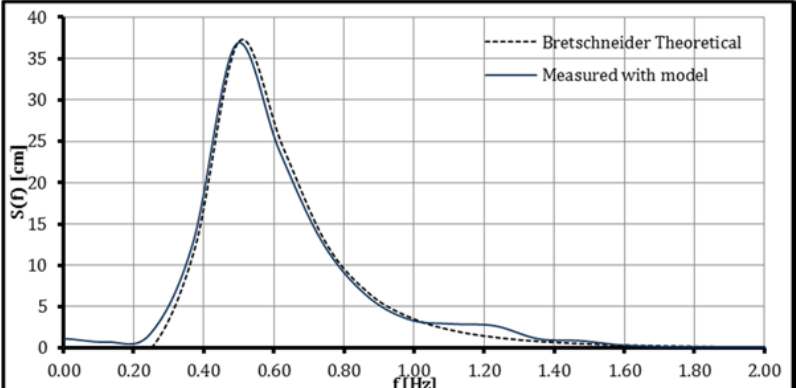
Figure 11. Water elevation η time series for Experiment #8.